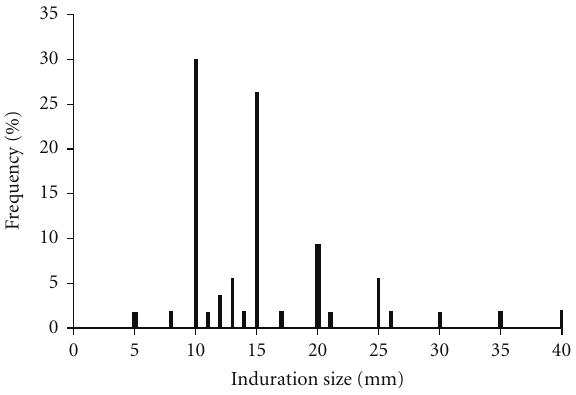
Figure 1: Distribution of TST induration size for inmates diagnosed with LTBI a,b,c . a Two inmates with TSTs < 10mm had previously tested positive ( > 10mm) and had been diagnosed with LTBI. b One TST result listed as 17–20 mm was input at 17mm. c One TST result listed as > 20 mm was input at 21 mm. LTBI: latent tuberculosis infection; TST: tuberculin skin test.